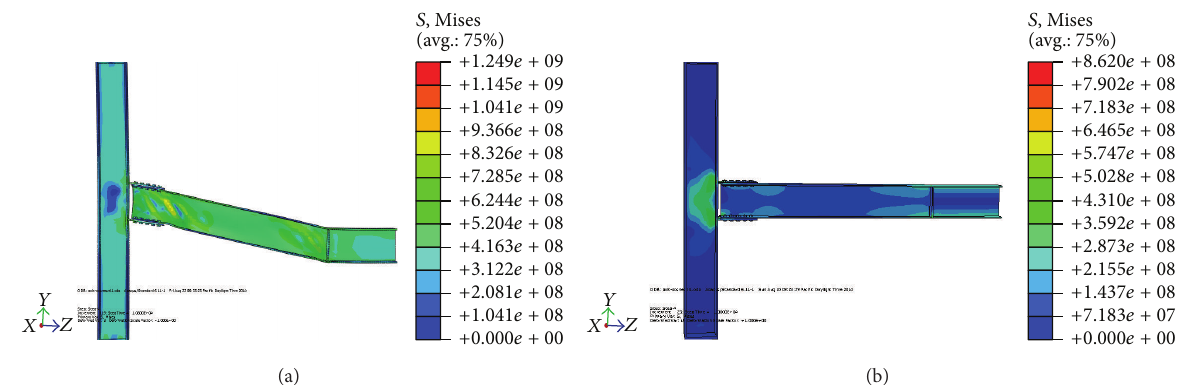
Figure 11: Connection with the cover plate: (a) with heat and (b) without heat.